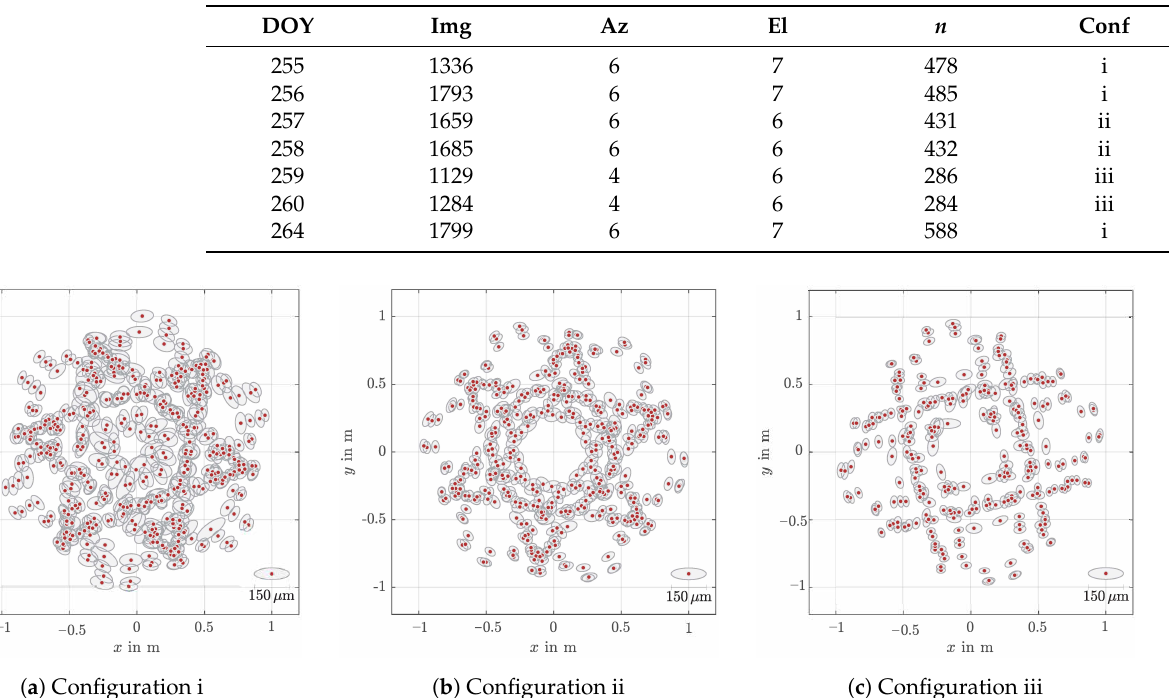
Table 1. Performed experiment configurations (Conf) w.r.t. to the number of telescope orientations in azimuth (Az) and elevation (El), the number of analyzable images (Img), and the effective number of marker positions n . The day of year (DOY) relates to 2020.